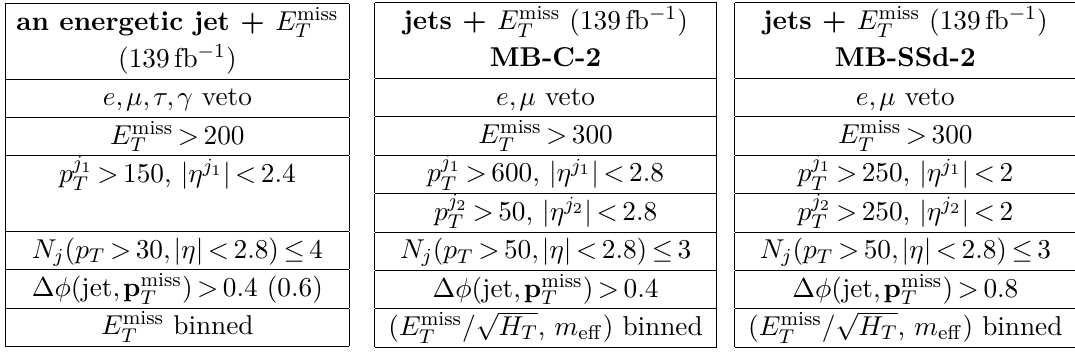
” (left) and the MB-C-2 (middle) and T ” analyses [5, 10], respectively. In the left table the T < 250 GeV. The unit of energy and momentum is T